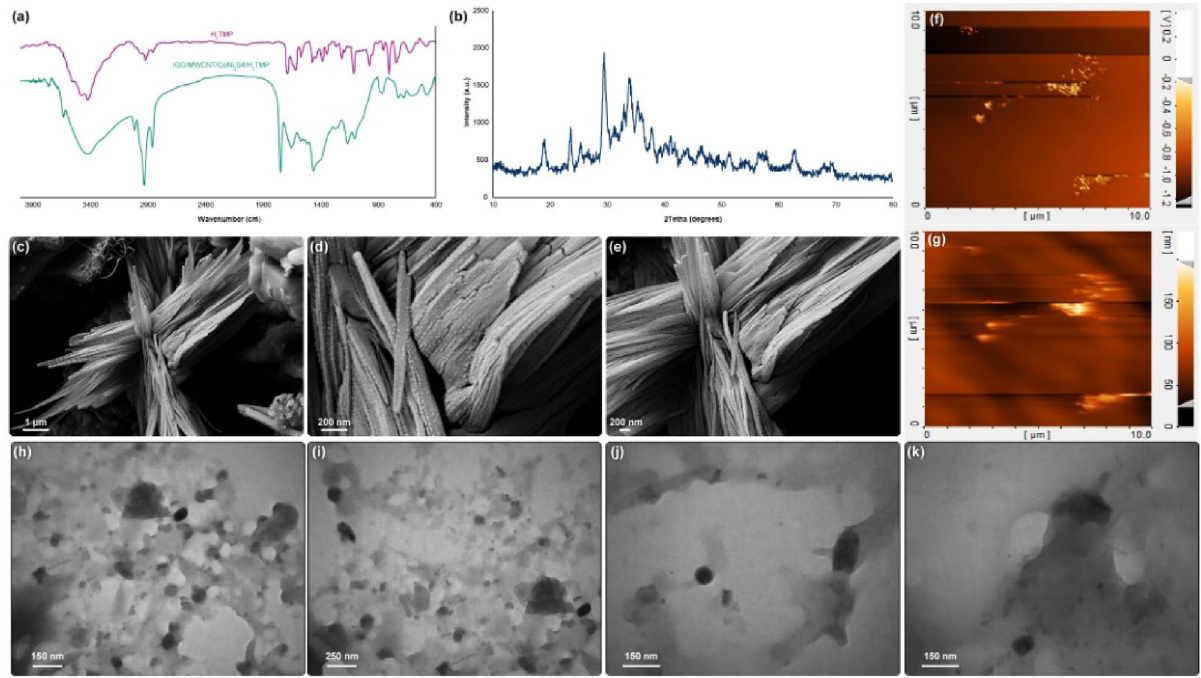
Figure 2. FTIR ( a ), XRD ( b ), FESEM ( c – e ), AFM ( f , g ) ,and TEM ( h – k ) of the synthesized